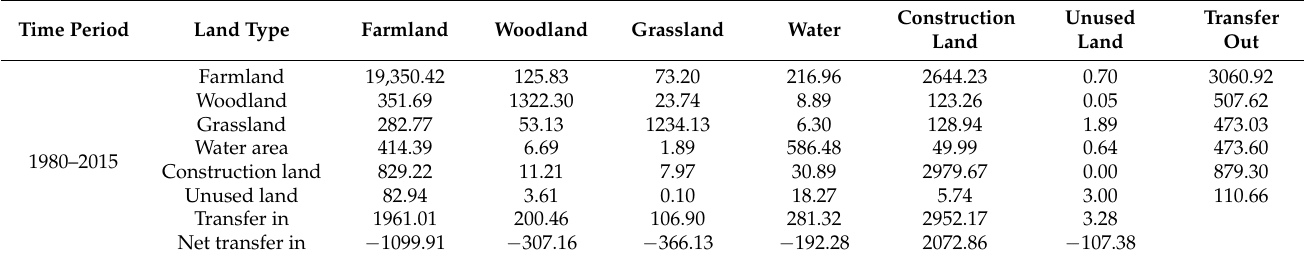
Table 2. Transfer matrix of land use area from 1980 to 2015 (km 2